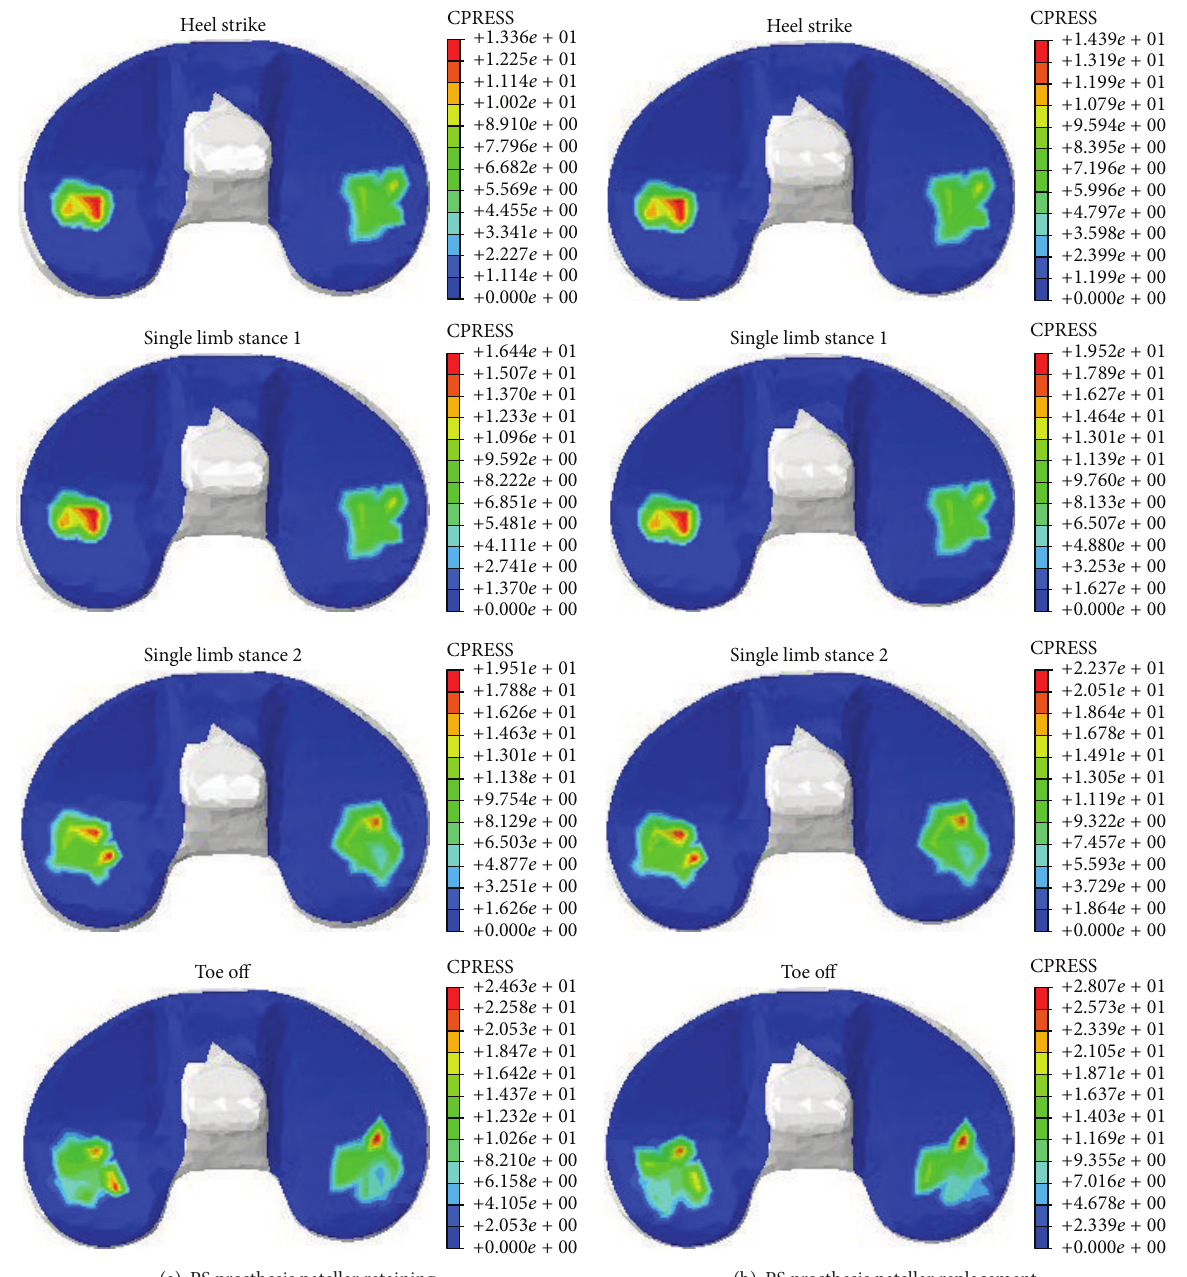
Figure 6: Stress contour of tibial tray during gait cycle.